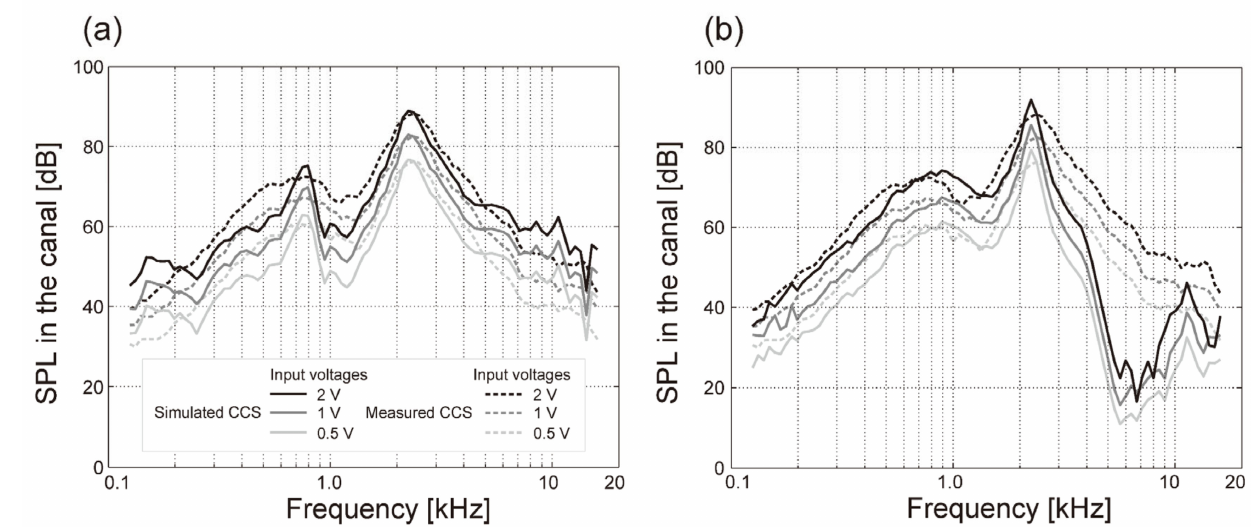
Figure 1. Simulated cartilage conduction sound (solid line) obtained in the ( a ) HATS and ( b ) model aural cartilage. The dashed lines indicate the measured cartilage-conduction sound obtained from the participants. The SPLs obtained in the human canal and by the HATS disagreed, especially in the low-frequency range below 1.5